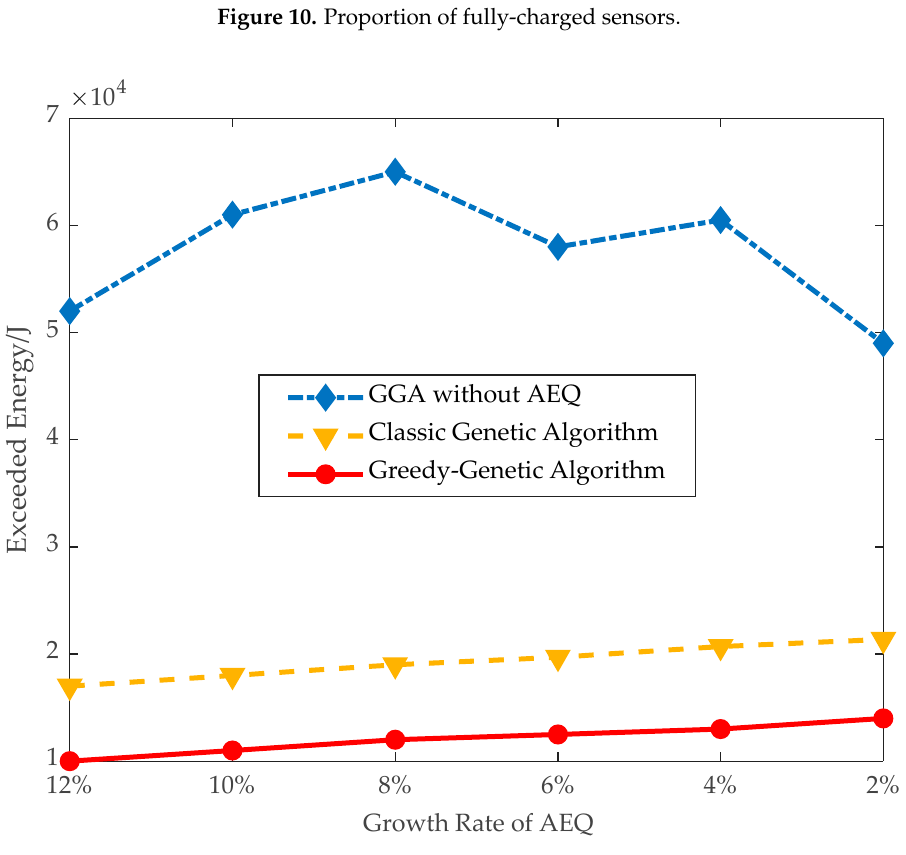
Figure 11. Exceeded energy.